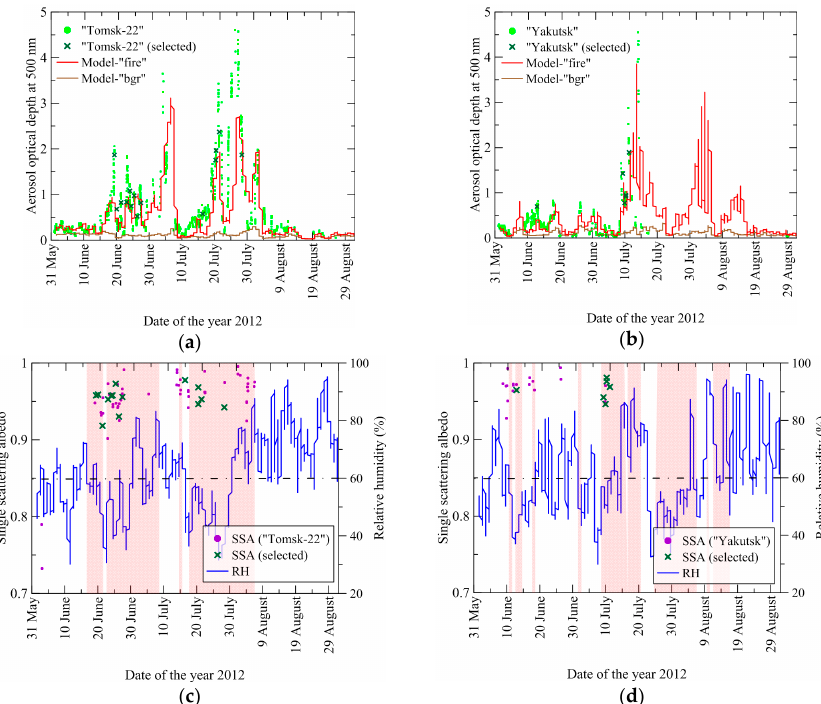
Figure 3. ( a , b ) Time series of AOD at 500 nm and ( c , d ) SSA at 675 nm according to the AERONET measurements at the ( a , c ) Tomsk-22 and ( b , d ) Yakutsk sites. Also shown are ( a , b ) the corresponding AOD data from the two CHIMERE runs, ”fire” and “bgr”, made with and without fire emissions, respectively, and ( c , d ) the ambient relative humidity (RH) in the BB aerosol columns. Dark green crosses indicate the points selected for our analysis based on the criteria specified in Section 2.1.1 and Table 1. The shaded areas ( c , d ) indicate the periods for which the AOD values from the “fire” run exceed the corresponding values from the “bgr“ run by more than a factor of three. The horizontal dash-dotted lines depict the RH threshold value used in one of the selection criteria.